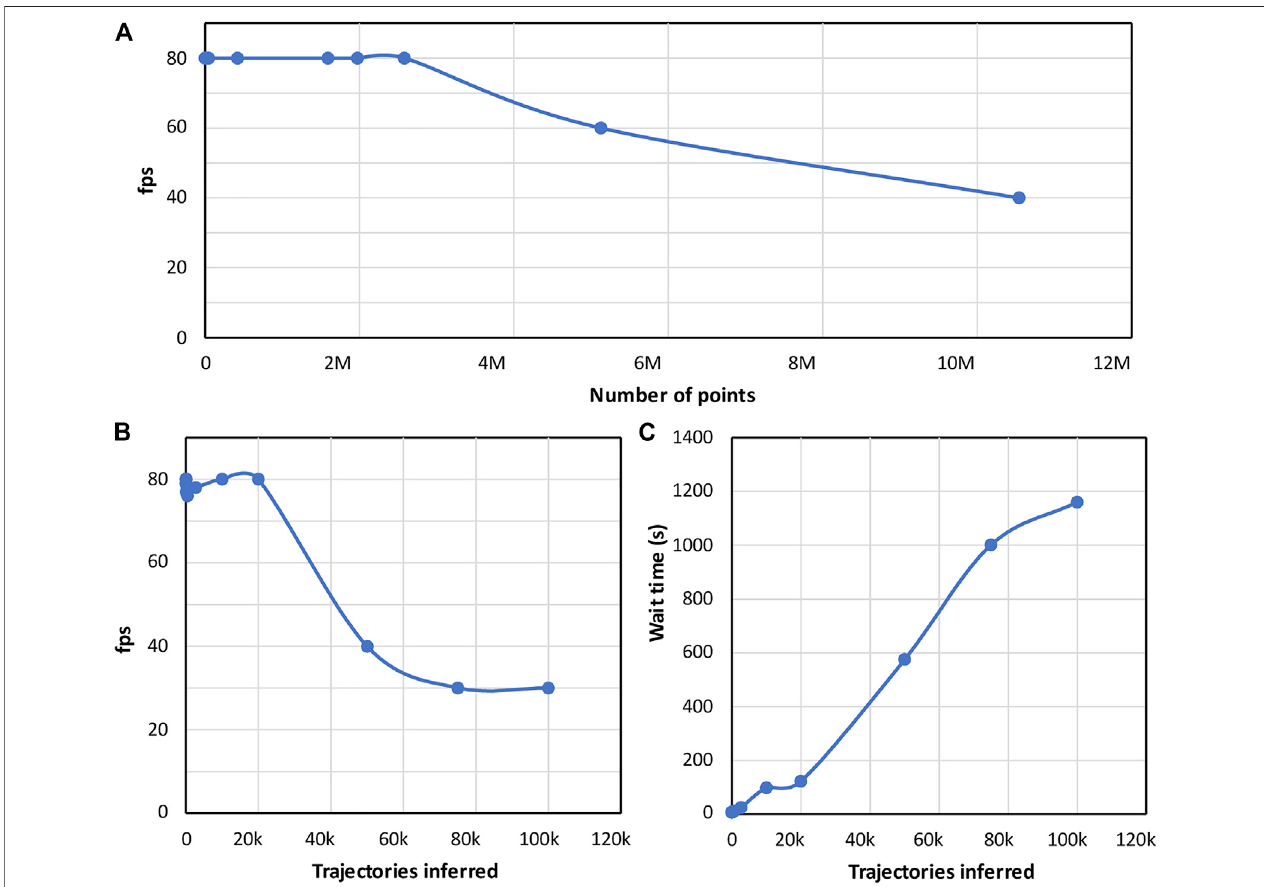
FIGURE 4 | Performance quanti fi cation: (A) The frame rate of the graphic card is reported as a function of the number of points that are visualized in VR. (B) Evolutionoftheframerateofthegraphiccardasafunctionofthenumberofthetrajectoriesthatareanalyzedusingthepre-trained neuralnetwork.Aframerateof80 Hz as imposed by the used VR headset de fi nes the range for a comfortable utilization of the VR headset. The refresh rate remains at a comfortable level for up to 30000 trajectories. Such number is considered extremely high compared to realistic data sets. (C) Evolution of computation time of the pretrained neural network as a function of the number of inferred trajectories. The reported analysis time is extremely fast regarding the computation required by the GNN. The performance quanti fi cations are performed for a computer with the following specs: Intel Core I5-8400 CPU, 16 Gb ram, Geforce 1080Ti